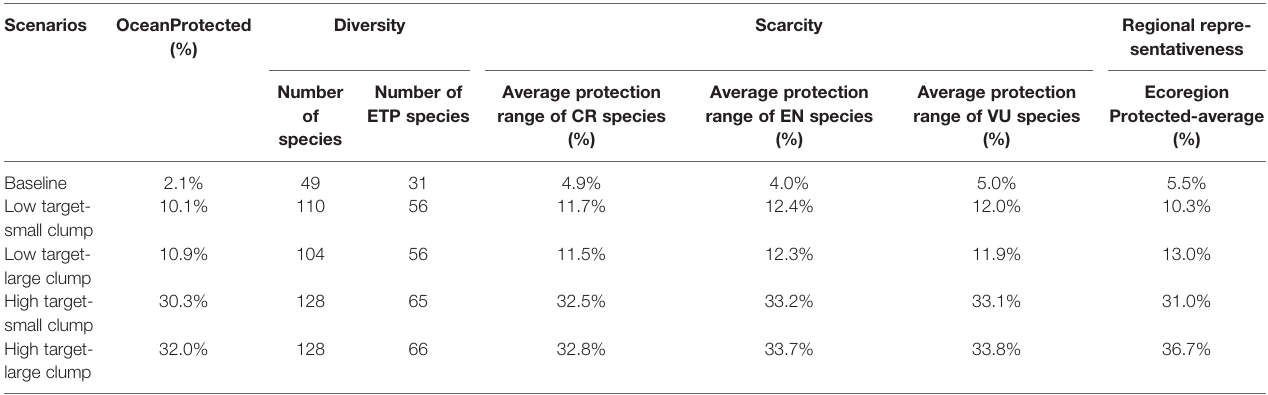
TABLE 4 | Conservation target achievements for different scenarios. Scenarios OceanProtected